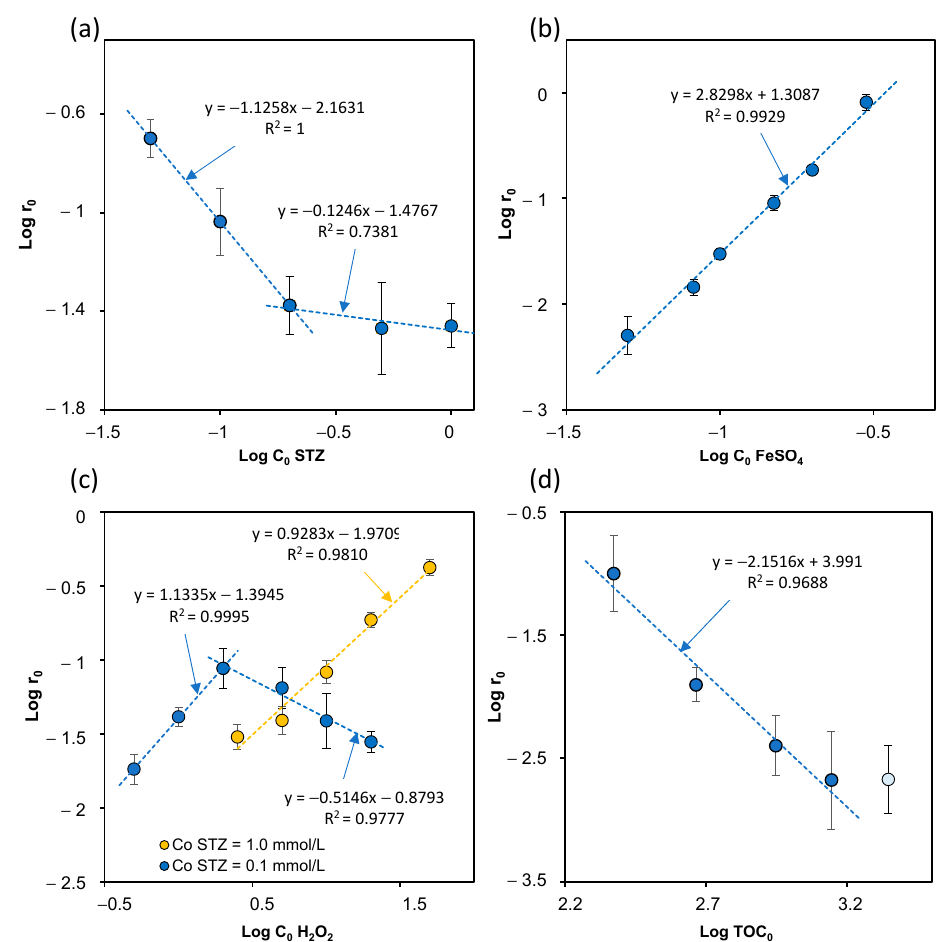
Figure 2. Determination of reaction order; the concentration effect of STZ ( a ), FeSO 4 ( b ), H 2 O 2 ( c ) and Total Organic Carbon (TOC) ( d ).